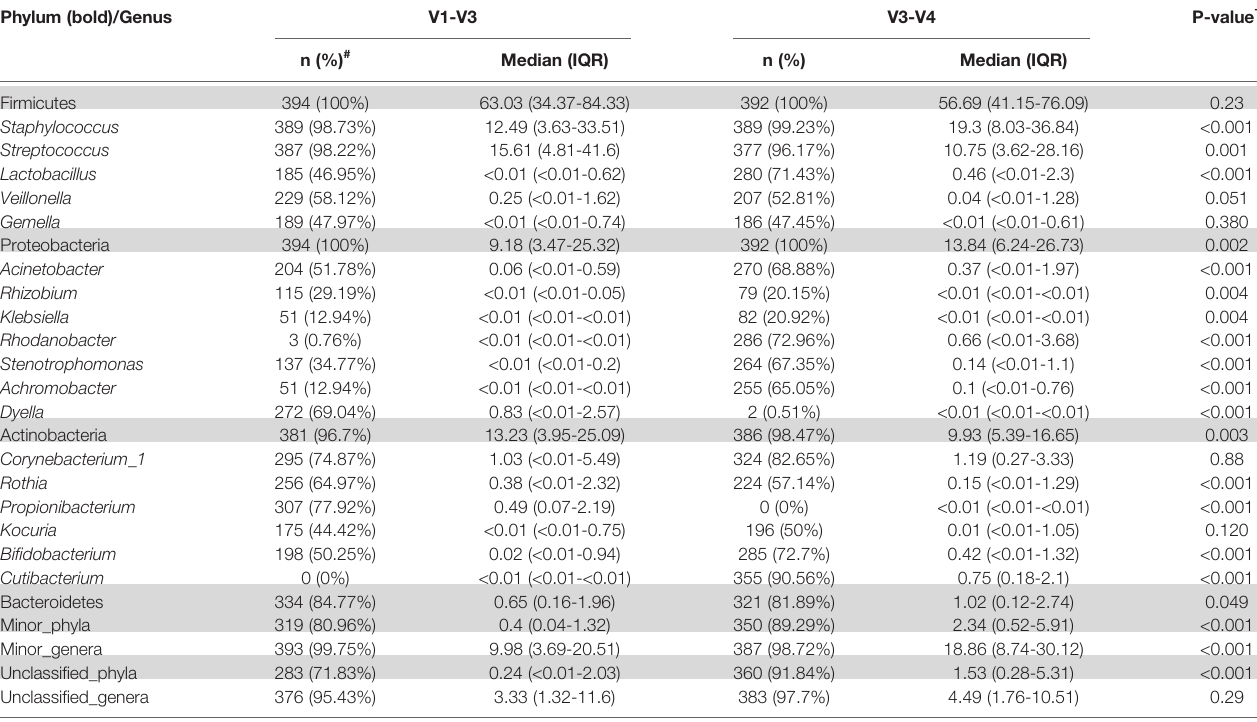
TABLE 5 | Relative frequencies, medians and interquartile range (IQR) of the most abundant bacterial phyla (bold) and genera detected in the milk samples analyzed either with the V3-V4 (this work) or the V1-V3 (Lackey et al., 2019) approach with SILVA 132 database. Phylum